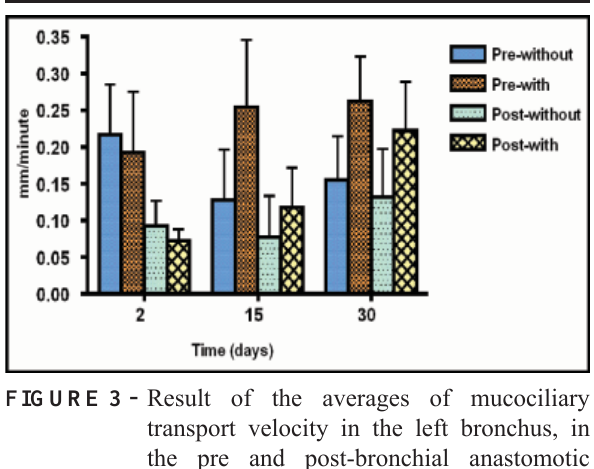
FIGURE 3 - Result of the averages of mucociliary transport velocity in the left bronchus, in the pre and post-bronchial anastomotic portion (p < 0.01). Without = without the administration of cyclosporine; With =